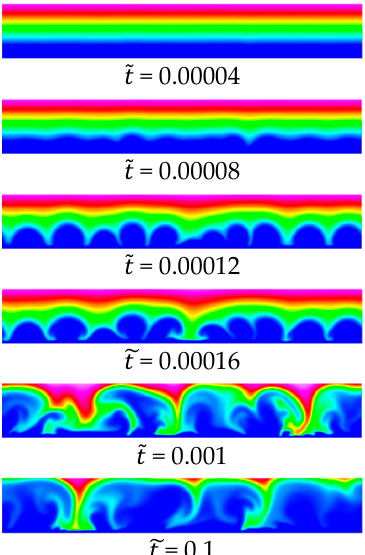
Figure 7. Baseline 2-D case ( 1 mol/m (cid:2871) concentration) , 𝑉 (cid:3556) = 120. Smooth membrane . Anion concentration.